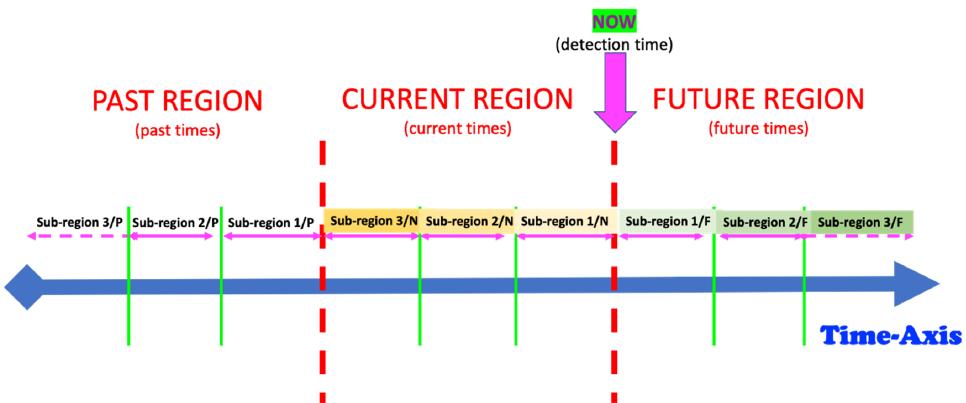
Figure 4. A possible and useful comprehensive structuring of the time dimension into regions and sub-regions. The use-case engineer shall fix meaningful durations/lengths of the different sub-regions. Table 2. Illustration of the time case (i.e., relative timing situation between detection and occurrence of the element to be assessed) perspective; see Figure 4.